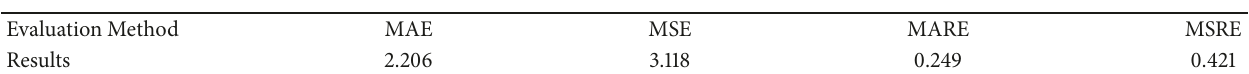
Figure 6: Division of service level within the bus. Table 7: Performance evaluation results.